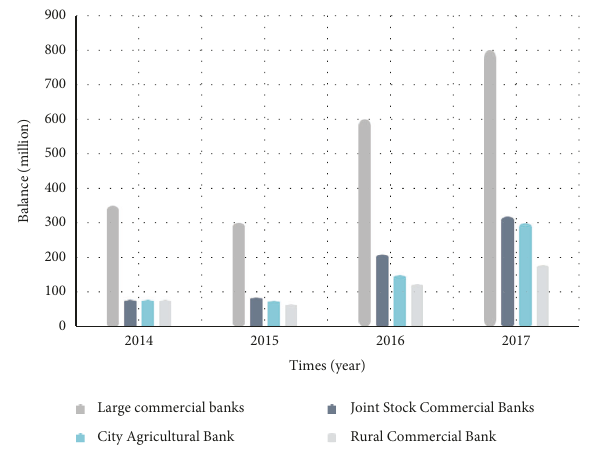
Figure 4: The quarterly nonperforming loan balance of com- mercial banks.